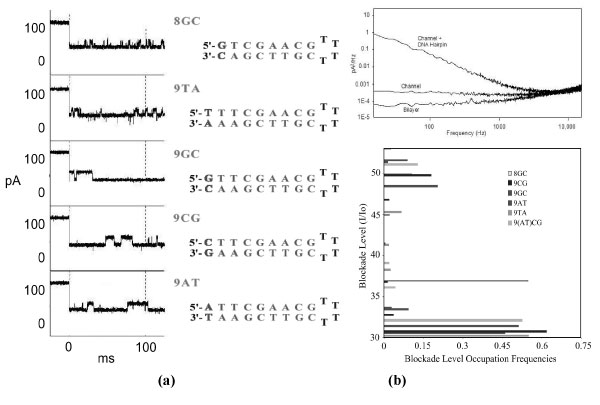
The channel current blockade signals observed in the prototype study (from [9]). Panel (a) shows the five DNA hairpins, with sample blockades, that were used to test the sensitivity of the nanopore device. Panel (b), top, shows the power spectral density for signals obtained from the different nine base pair DNA hairpins, as well as the open channel. Panel (b), bottom, shows the dominant blockades, and their frequencies, for the different hairpin molecules in panel (a).